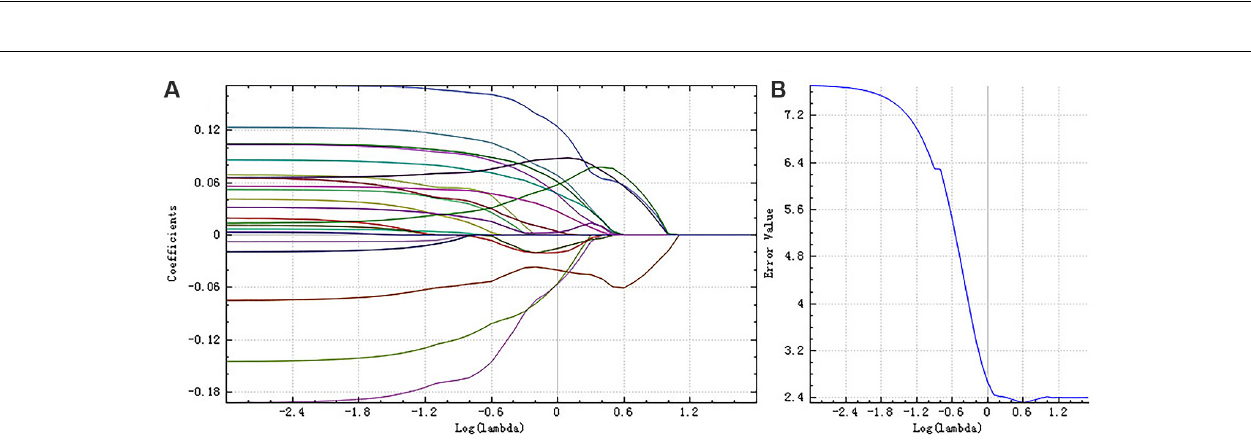
FIGURE 4 | The coefficients-lambda graph (A) and the error-lambda graph (B) of the right hippocampus. We chose the λ corresponding to the lowest error rate.